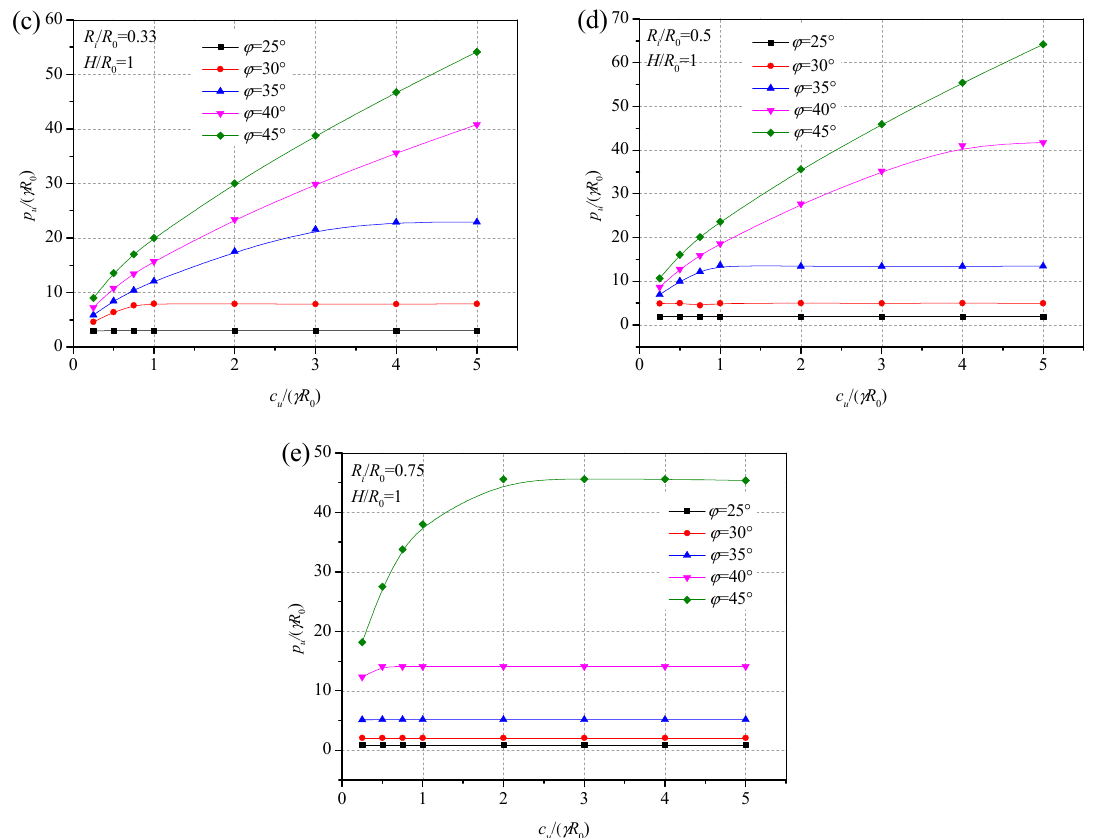
Figure 3. Variation in the normalized bearing capacity, p / ( γ R 0 ), with c u / ( γ R 0 ) and ϕ for H / R 0 = 1 with ( a ) R i / R 0 = 0, ( b ) R i / R 0 = 0.25, ( c ) R i / R 0 = 0.33, ( d ) R i / R 0 = 0.5, and ( e ) R i / R 0 = 0.75.